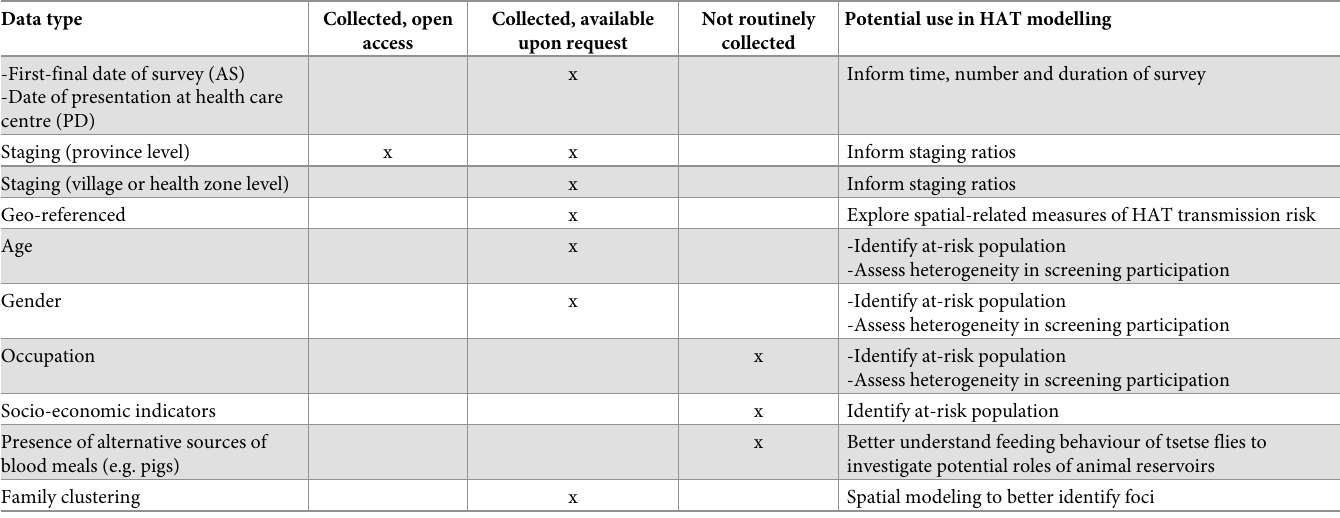
Table 4. Summary of relevant data and its potential use in HAT